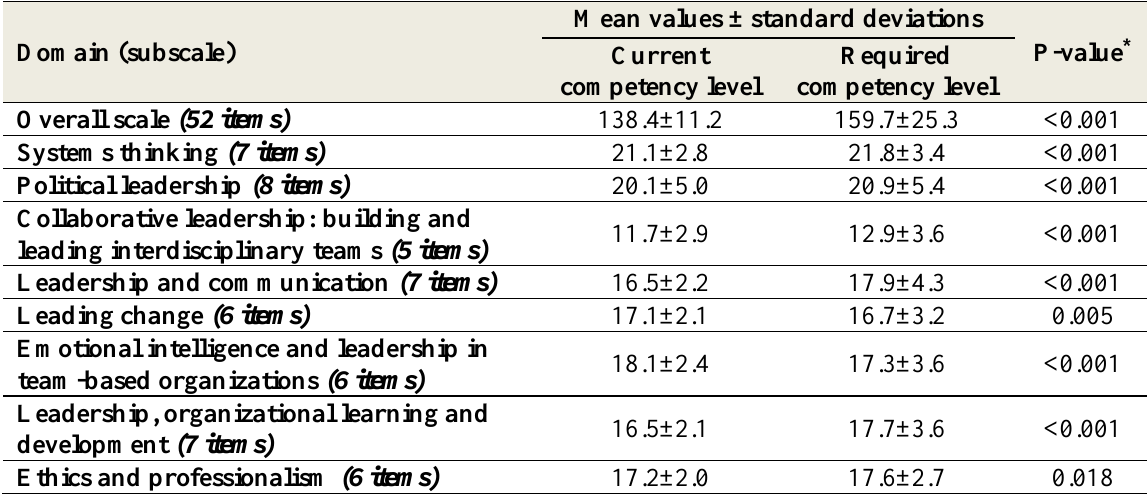
Table 3. Summary score of each domain (subscale) of the leadership competency instrument for the current and the required competency level of Albanian health professionals (N=267) Domain